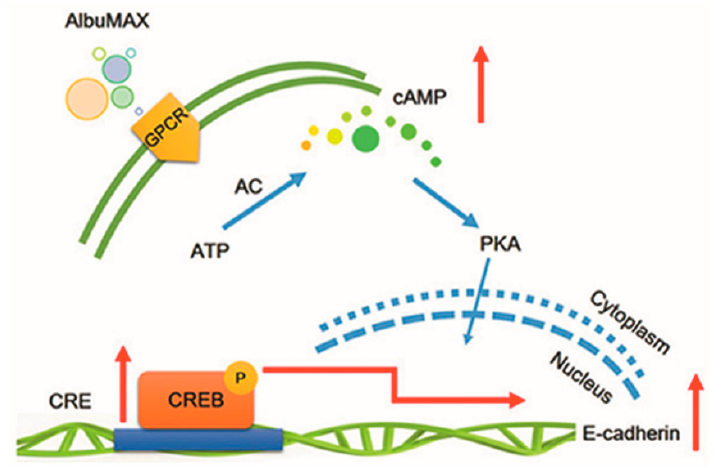
Figure 7. Schematic diagram of AlbuMAX working model in reprogramming.